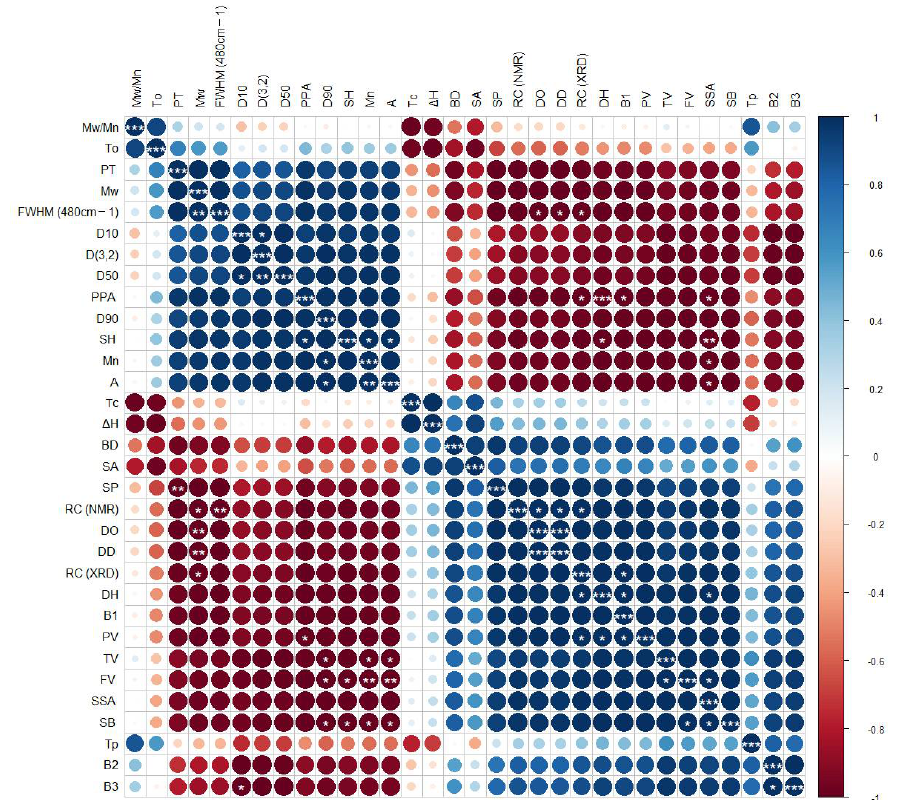
Figure 4. Correlation heat map of different parameters of starch samples extracted by different methods. * is p ≤ 0.05, ** is p ≤ 0.01, and *** is p ≤ 0.001.